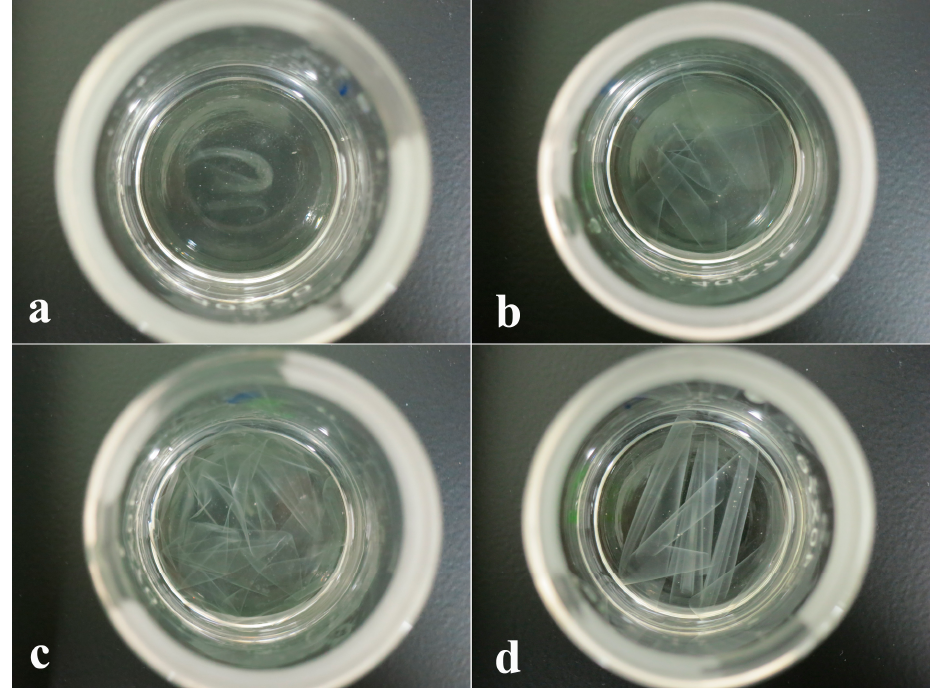
Figure 1. Solubility of films after immersion in DMSO for 1 h. ( a ) APF/G0, ( b ) APF/G0.25, ( c ) APF/G0.5, ( d ) APF/G1.